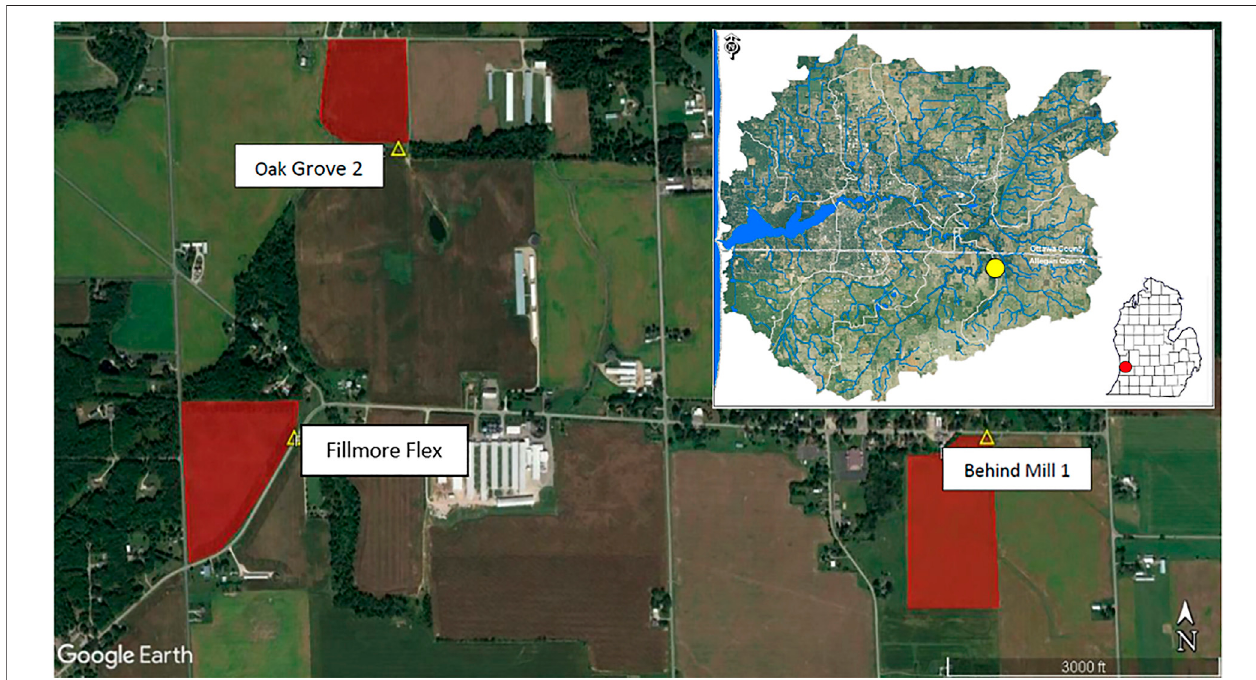
FIGURE 1 | Completed EAF slag fi lter sites are indicated by yellow triangles, the red polygons represent the adjoining fi elds being drained, each approximately 30 acres.FillmoreFlexand OakGrove2sites fl owintothesouth branchoftheMacatawa River, whichlaterjoinsthemainbranchoftheMacatawa River. BehindMill 1 fl ows into Peter ’ s Creek. Insert: location of sites within the Macatawa watershed (yellow circle) and location within the lower peninsula of Michigan (red circle).